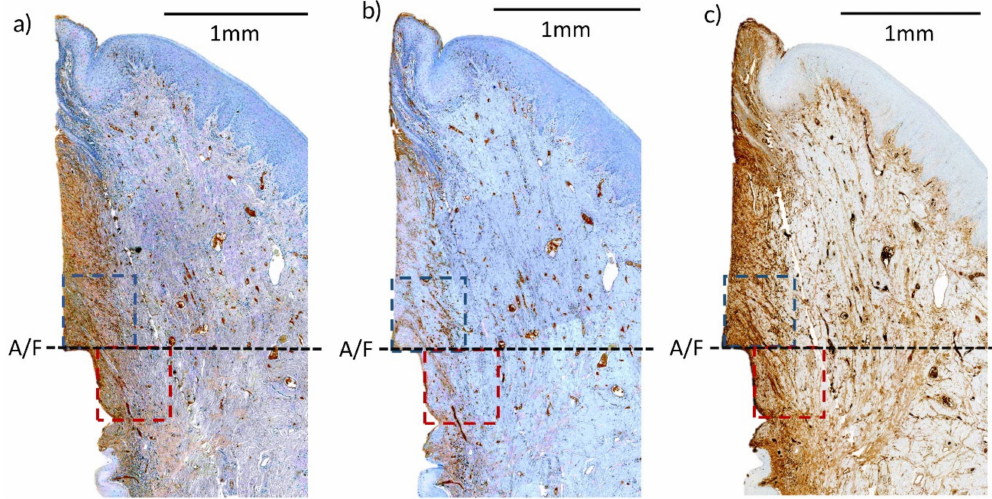
Figure 4. Immunohistochemical (IHC) stained histological slides of di ff erent types of primary antibody—( a ) CD3, ( b ) CD20, ( c ) IgG antibody. A / F—abutment-fixture junction; upper (blue) and lower (maroon) region of interest (ROI) selected for cell marker intensity